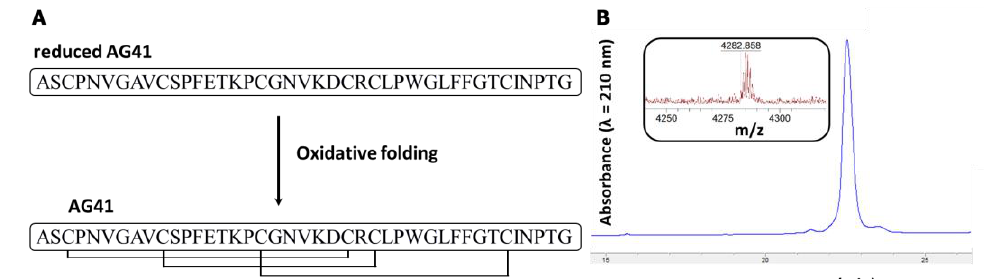
Figure 2. Chemical synthesis of AG41. ( A ) Schematic representation of the AG41 peptide oxidative folding. ( B ) RP-HPLC chromatogram and MALDI-TOF mass spectrum of the purified folded pep- tide .